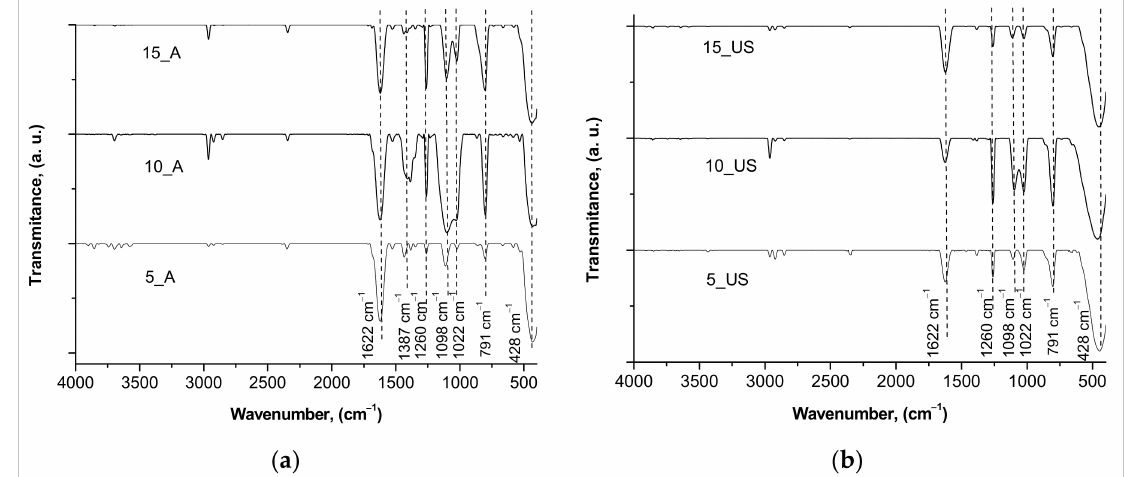
Figure 4. FTIR spectra registered for the ( a ) A-series and ( b ) US-series titania